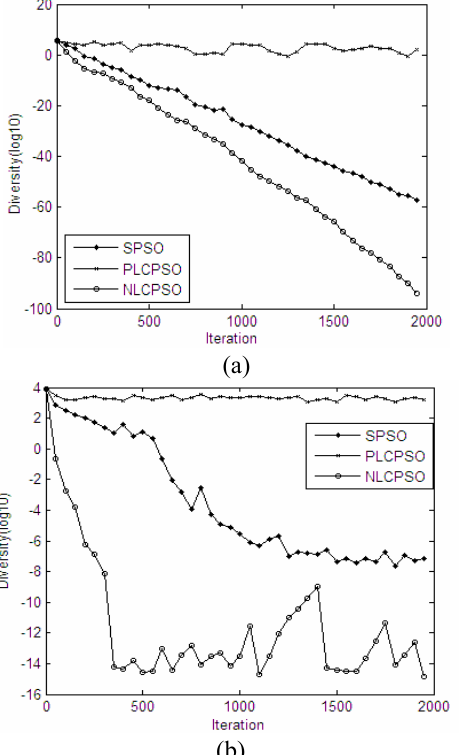
Fig.1 Comparison of SPSO’s, PLNPSO’s and NLSPSO’s population diversity. (a) Curve of population diversity for Shpere function. (b) Curve of population diversity for Rastrigin